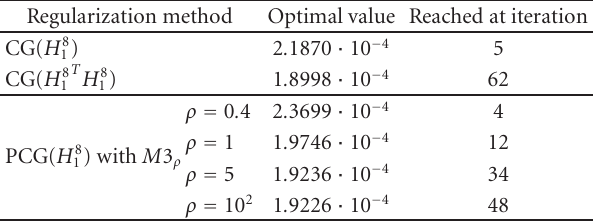
Table 3: Optimal reconstruction error (cid:2) x 1 − (cid:4) x 1 (cid:2) 2 for the 1D operator H 8 1 and original data x 1 of size n = 10 3 a ff ected by random noise of order 0.01%.